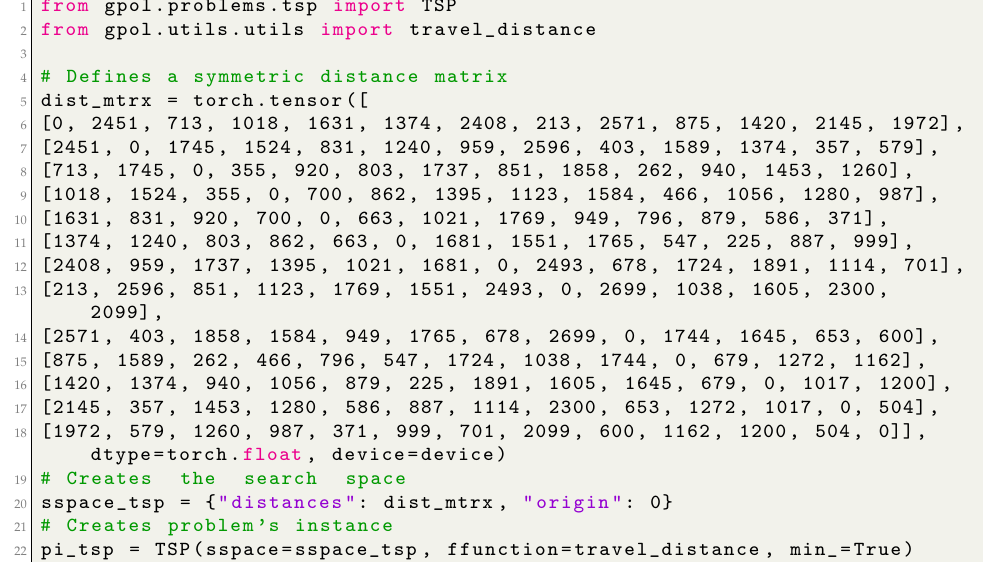
Figure A2. A demonstration of how to create an instance of the TSP